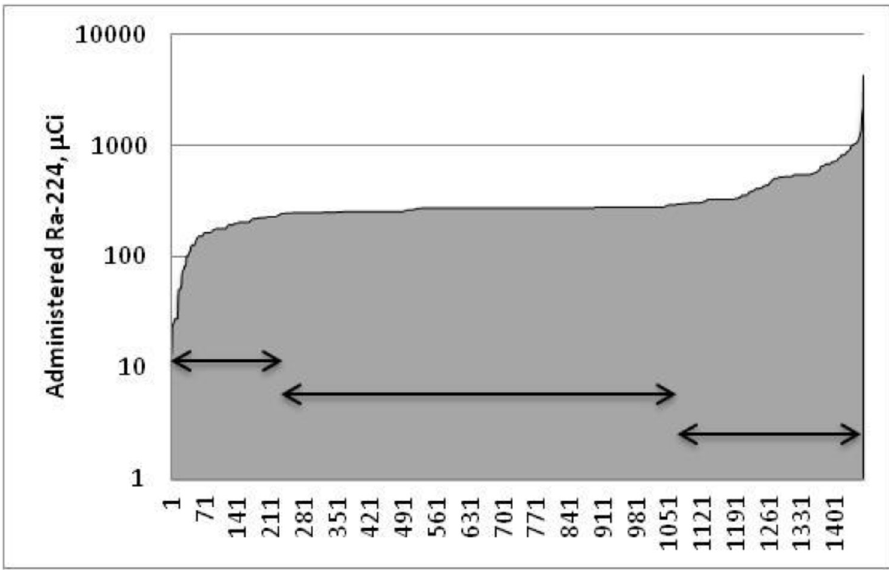
Fig 1. Graph showing amount of 224 Ra administered by patient number. 820 male patients (centre arrow) that received the target treatment dose of approximately 10.3MBq of radium chloride were selected for comparison with the control